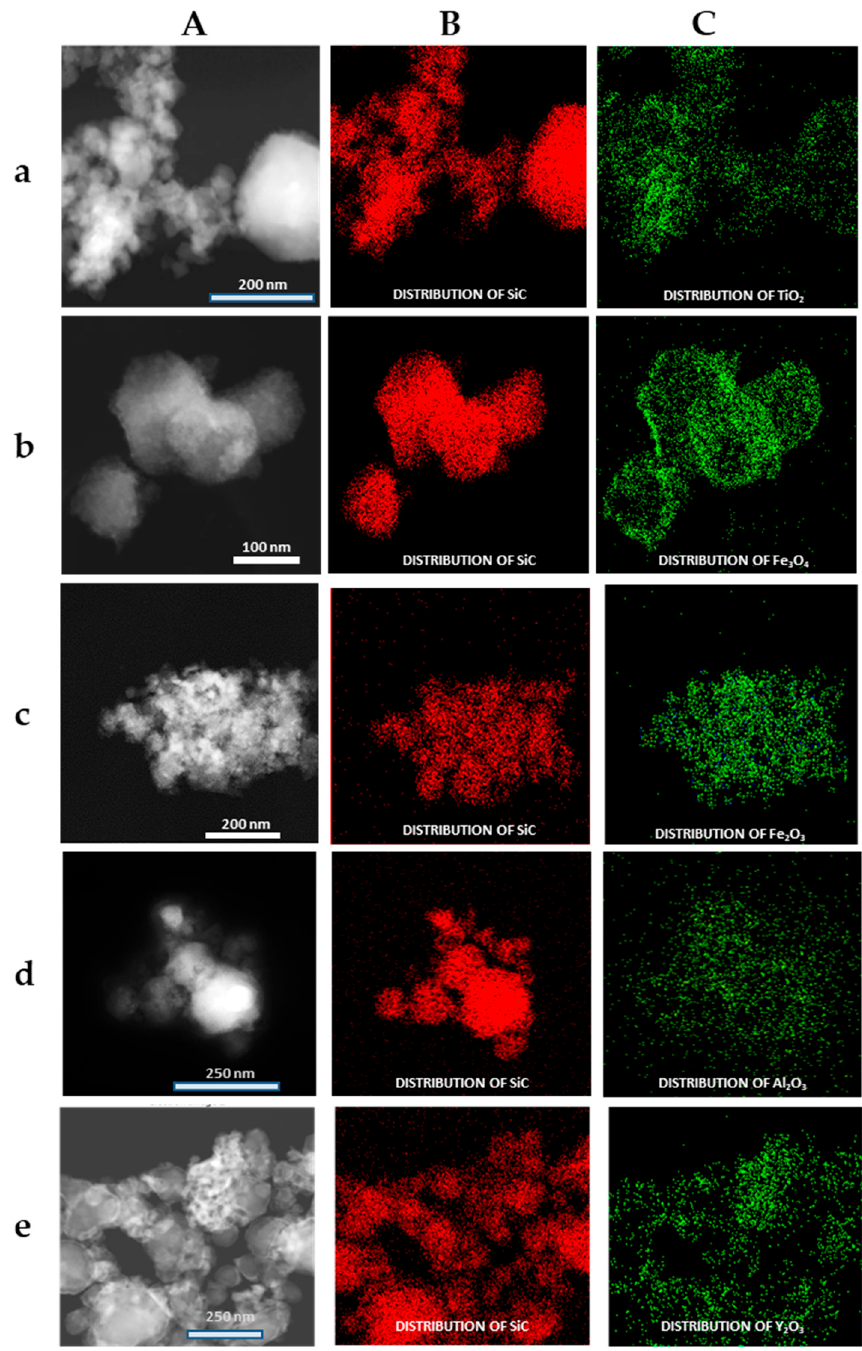
Figure 5. Representative images of the M x O m @SiC core–shell nanoparticles (NPs) obtained at lab scale (EDX-STEM, mapping tool). ( A ) Direct electron image; ( B ) Signal coming from the SiC particles (Si K α 1 radiation); and ( C ) Signal coming from the shell (corresponding M K α 1 radiation). ( a ) TiO 2 @SiC; ( b ) Fe 3 O 4 @SiC; ( c ) Fe 2 O 3 @SiC; ( d ) Al 2 O 3 @SiC; and ( e ) Y 2 O 3 @SiC. EDX: X-ray